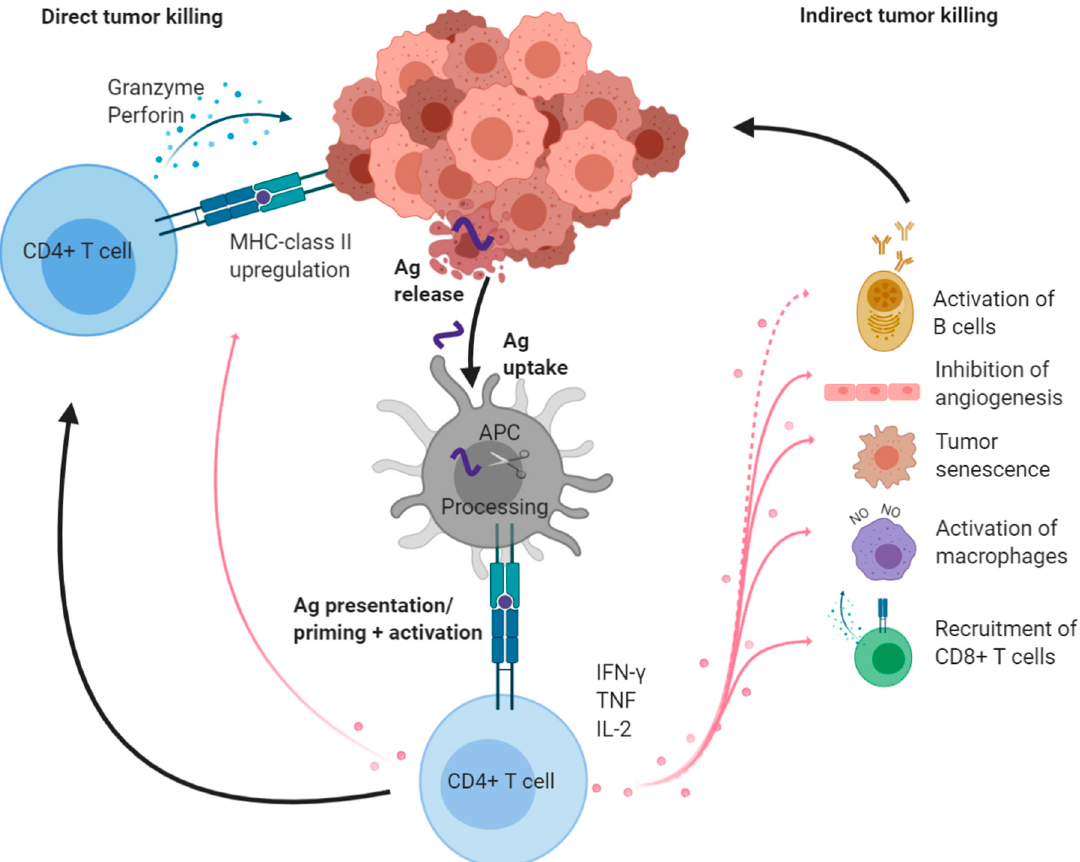
Figure 1. Overview of CD4+ T helper cell tasks in antitumor immunity. After priming and differentiation, effector cytotoxic CD4+ T cells can kill MHC-class II+ tumors directly by, e.g., the release of perforin and granzyme (left). CD4+ Th cells produce IFN- γ , TNF, and IL-2, which have pleiotropic effects on immune or non-immune cells in the TME (right). Activated CD8+ CTLs and NO-producing macrophages participate in tumor elimination and amplify local antitumor immunity via the release of further tumor antigens. IFN- γ and TNF drive tumor senescence and inhibition of angiogenesis. Activated B cells are found in human tumors, however, their exact function is still unclear (dotted line). Created with BioRender. Ag: antigen; NO: nitric